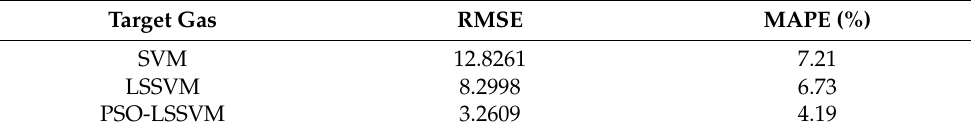
Table 14. Ethylene concentration prediction results of different algorithms under the full-sample selection strategy.